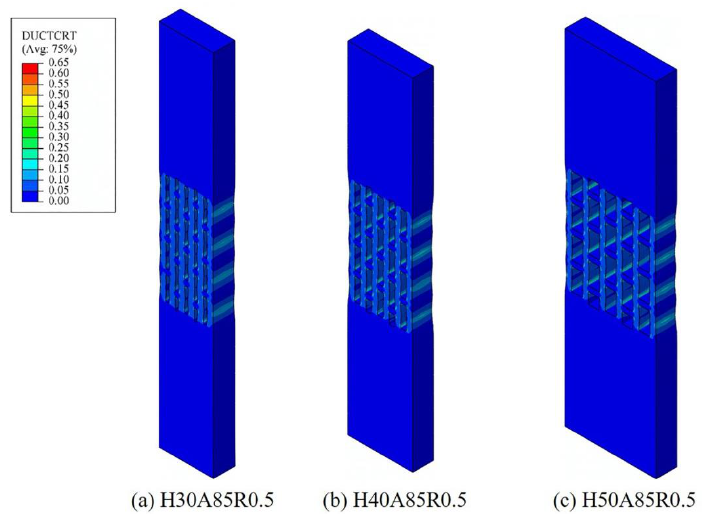
Figure 12. Effect of hole ratio on damage index with (a)H30A85R0.5 (b)H40A85R0.5 and